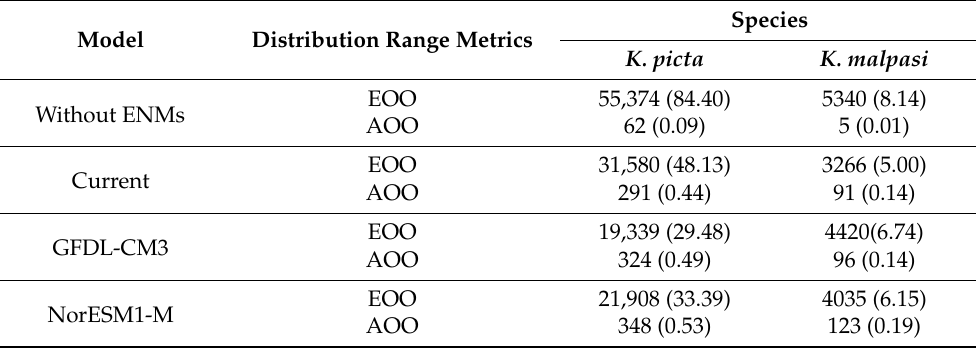
Table 5. The extent of occurrence (EOO) and area of occupancy (AOO) of K. picta and K. malpasi in both current and future distribution scenarios as predicted by the ENMs in comparison with the same metrics calculated by the georeferenced points following IUCN